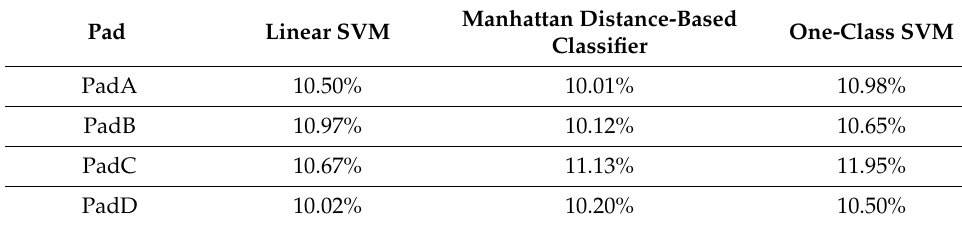
Figure 9. EER for removal of the lower 40% features. Table 7. EER for removal of the lower 40%